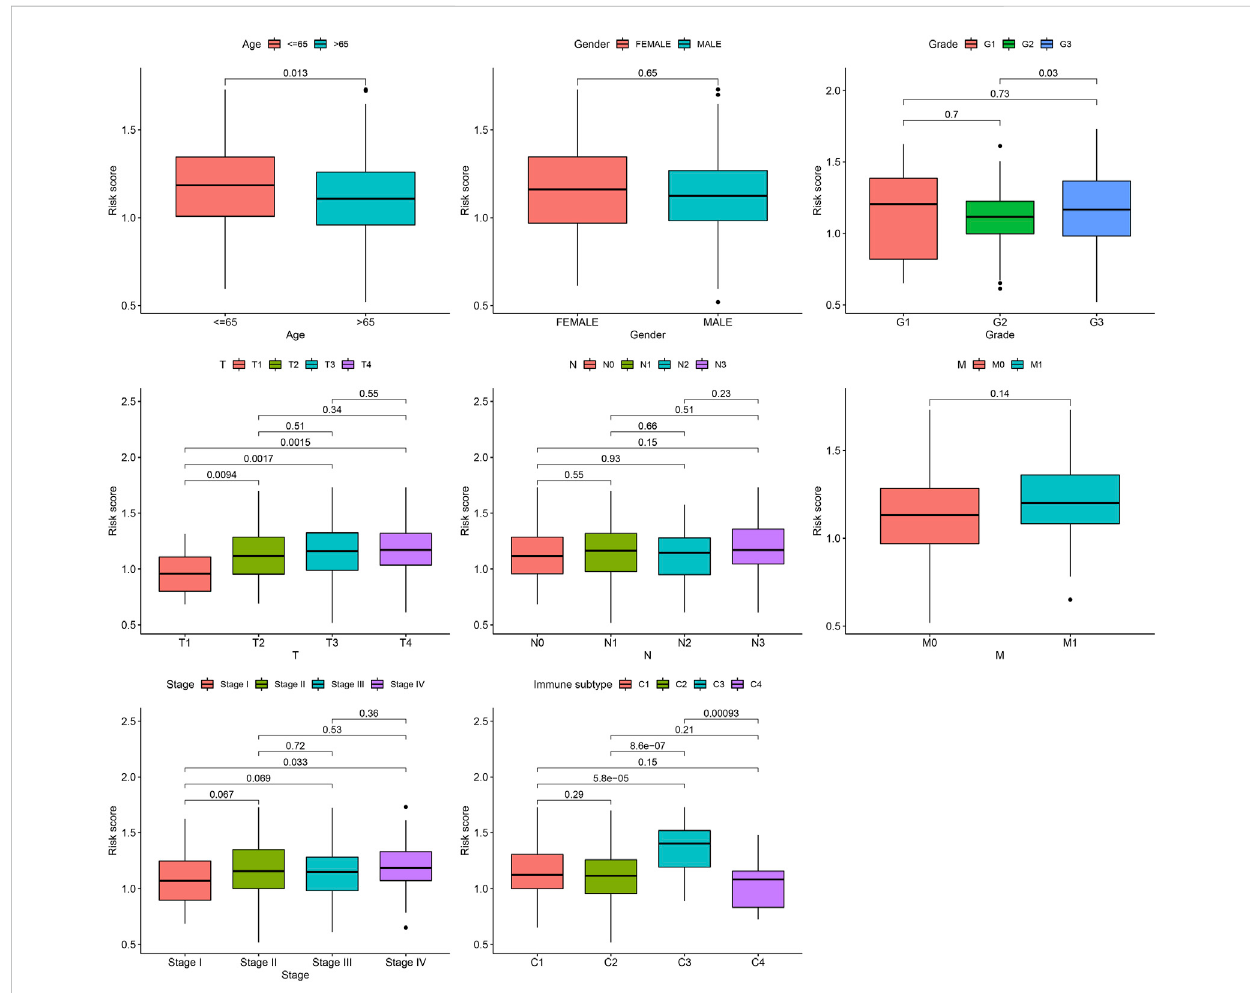
FIGURE 8 Risk score variation of different risk GC in different